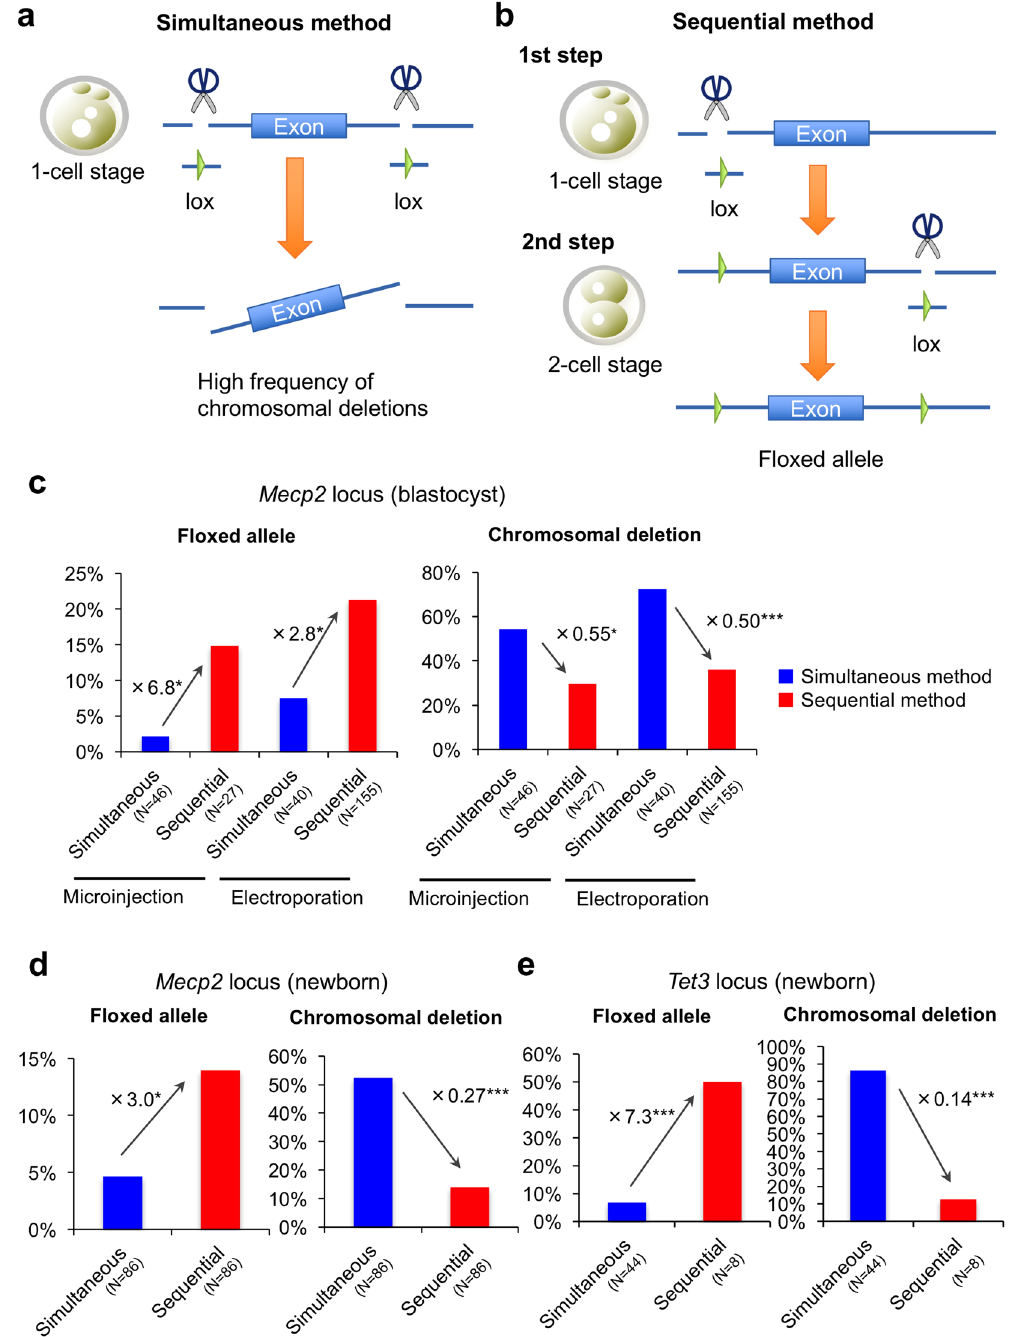
Figure 1. The novel sequential method results in an efficient rate of allele floxing at Mecp2 and Tet3 loci. Schematic of experimental procedures for ( a ) an ordinary simultaneous method and ( b ) a novel sequential method for generating flox mice. ( c ) In blastocyst embryos, the sequential methods led to less chromosomal deletion and more floxed alleles at the Mecp2 locus than the simultaneous methods. The data using optimal conditions are shown. The optimal conditions for microinjection were 50/12/200 (ng/ μ l) of Cas9/gRNA/ ssODN, and those for electroporation were × 7 (simultaneous) or × 7, × 7 (sequential) electric pulses using 100/24/400 (ng/ μ l) of Cas9/gRNA/ssODN. For detailed information, see also Table 1. In newborn mice, sequential electroporation also resulted in fewer chromosomal deletions and more floxed alleles at Mecp2 ( d ) and Tet3 ( e ) loci than simultaneous electroporation. For detailed information, see also Tables 3 and 4. * P < 0.05, *** P <